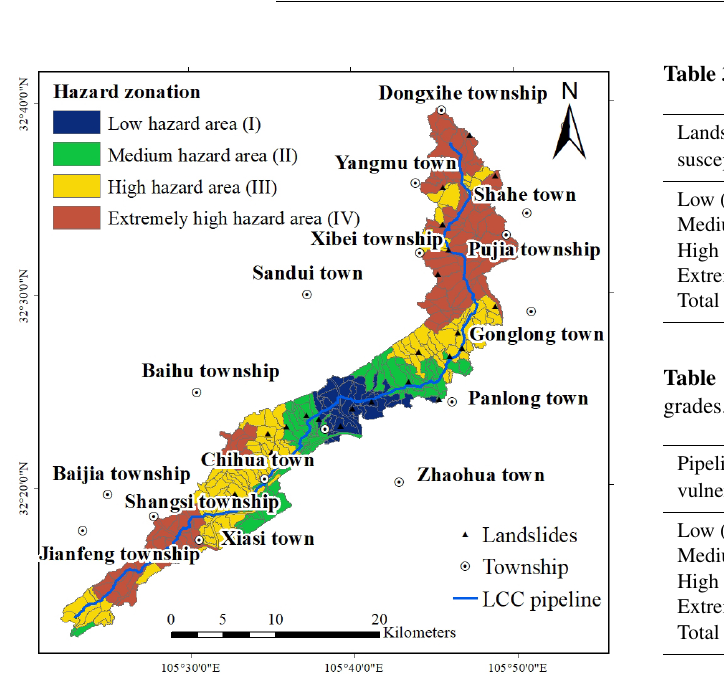
Figure 5. Landslide hazard map of study area.